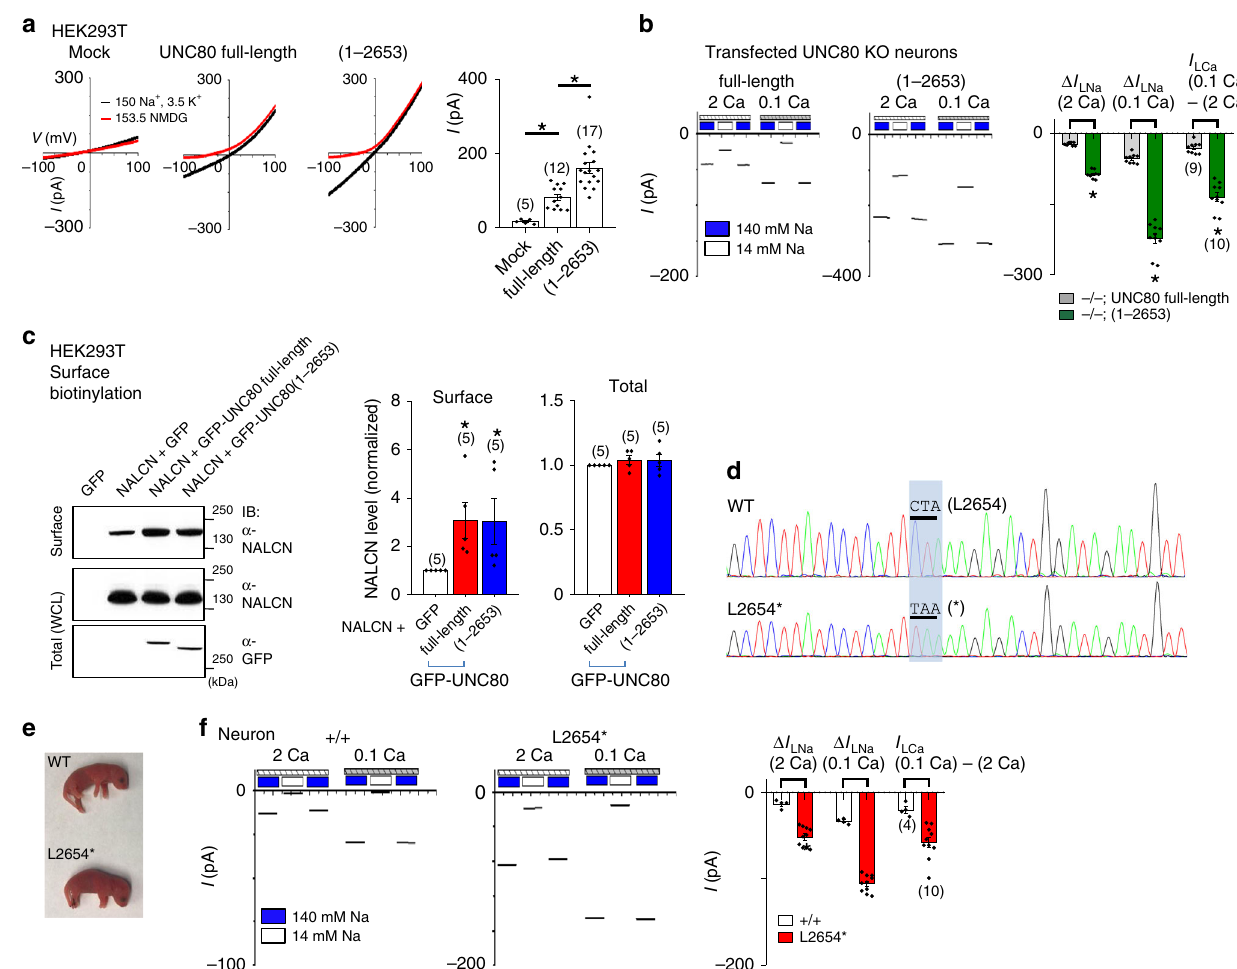
Fig. 6 UNC80 ’ s C-terminus truncated in human patients is not required for whole-cell I NALCN but is essential for survival. a , b I NALCN ( a done as in Fig. 5b, averaged amplitudes at − 100 mV given in the bar graph) or Na + -leak current ( Δ I LNa ) ( b ) from HEK293T cells ( a ) or cultured UNC80 KO neurons ( b recorded with 2 mM Ca 2 + (2 Ca) or 0.1 mM Ca 2 + (0.1 Ca) in the bath) transfected with full-length or mutant UNC80 truncated at L2654 (aa1 – 2653). c Surface biotinylation assays. Left, representative western blots. Surface proteins in cells transfected with cDNA combinations as indicated were biotinylated, isolated using streptavidin-conjugated beads, and probed with α -NALCN. Total protein (whole-cell lysate, WCL) was probed with α -NALCN or α -GFP. In the lower panel, GFP alone in the control lane migrated at ~20 kDa (outside the molecular range shown) and is not visible in the blot. Right, quanti fi cation. Signal intensity of each band from cells co-transfected with NALCN and full-length or truncated UNC80 was normalized to that from cells co-transfected with NALCN and GFP. d Sanger sequencing of the knock-in mice (L2654*, lower) and WT (upper). In the L2654* mice, the leucine- encoding codon (CTA, L2654) is mutated to a stop codon (TAA,*). e Representative appearances of WT and homozygous L2654* mutant P0 pups. For apnea phenotypes, see Supplementary Movie 2. f Δ I LNa recorded from neurons cultured from WT and L2654* pups. Data are presented as mean values ± SEM. In the bar graphs, numbers of recordings or repeats are in parentheses. Two sample t tests were performed. Asterisk “ * ” indicates p < 0.05. p values are as follows. a (against the “ full-length ” group): “ Mock ” ( p ≤ 0.001), “ 1 – 2653 ” ( p ≤ 0.001), b (between the group of “ − / − ; UNC80 full-length ” (full- length UNC80-transfected) and the group of “ − / − ; (1 – 2653) ” (truncation mutant-transfected)): Δ I LNa (2 Ca) ( p ≤ 0.001), Δ I LNa (0.1 Ca) ( p ≤ 0.001), Δ I – 2 Ca) ( p ≤ 0.001), c (against the group of “ GFP ” (GFP-transfected)): “ full-length ” ( p = 0.025), “ 1 – 2653 ” ( p = 0.049). Source data are LCa (0.1 Ca provided as a Source Data fi UNC80 truncated at aa 2233 (Supplementary Fig. 2c), aa 1265 UNC80 from the C-terminus up to 326 aa (UNC80 (1 – 3000), (Supplementary Fig. 2d), or aa 2387 (Supplementary Fig. 2e), Supplementary Fig. 2b) started to compromise UNC80 ’ s similar to WT, was found in both soma and dendrites, suggesting localization, as the truncated protein had limited dendritic the existence of the soma-retention domain between ~aa localization in some neurons (Supplementary Fig. 2b, upper 2300 – 2600. Consistent with this idea, a fragment of 525 amino panels) but was restricted to soma in the other (Supplementary acids alone in the region (aa 2234 – 2657) was suf fi cient to retain Fig. 2b, lower panels). Together, these data suggest that the distal GFP in soma (Fig. 7d). C-terminal ~300 aa (before ~aa 3000), while not required for the generation of whole-cell I NALCN , mediates UNC80 ’ s dendritic localization. The requirement of a C-terminal domain for dendritic UNC80 ’ s C-terminus interacts with UNC79 . UNC80 interacts localization also suggests the existence of a soma-retention signal with both NALCN and UNC79 20 . We used immunoprecipitation that prevents UNC80 ’ s diffusion from soma to dendrites. Indeed, assays in transfected HEK293T cells to test whether the disease-